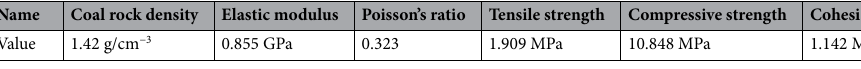
Table 1. Rock material parameters.